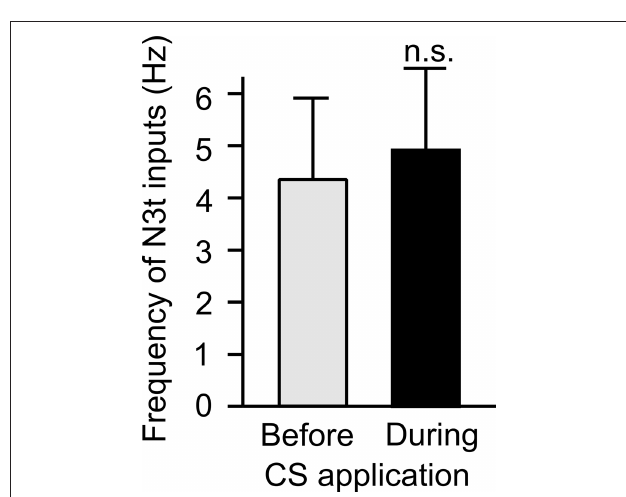
Figure 4 | CS application does not change the frequency of the N3t inputs on the B3. The frequency of N3-driven EPSPs on the B3 was measured immediately before and during CS application following pairing. The data from eight preparations tested at different time points after pairing were combined, no statistically significant difference can be observed using a two-tailed paired t -test ( P >